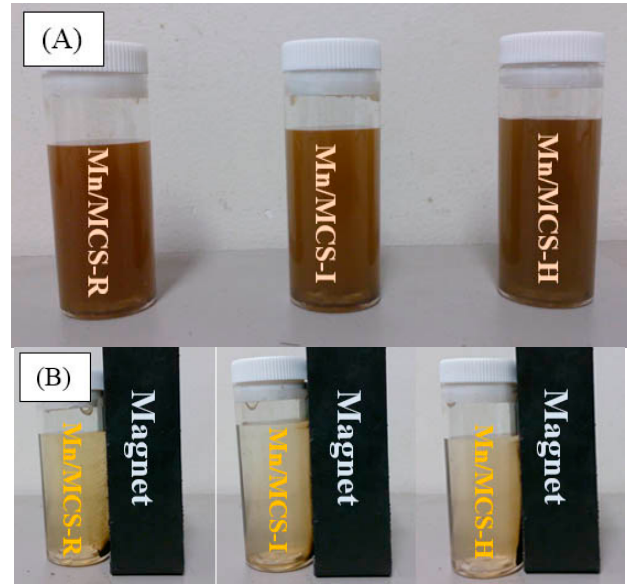
Figure 9. Photographs of the separation and dispersion processes: ( A ) without external magnetic field; and ( B ) with external magnetic field.